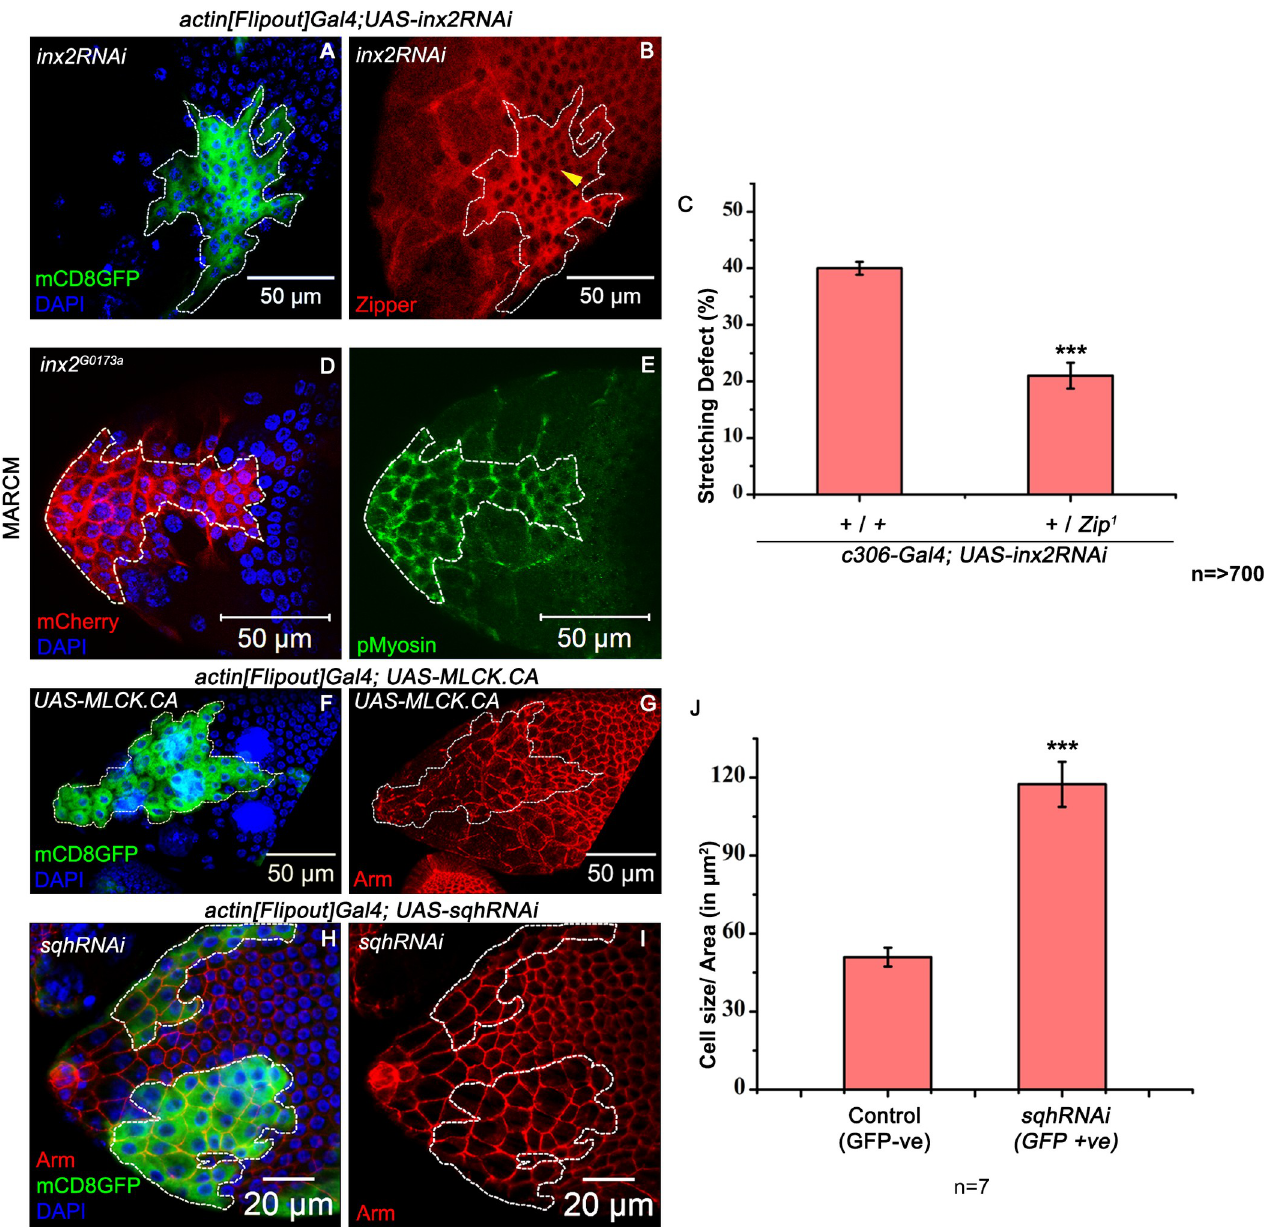
Fig 5. Inx2 influences myosin activity to execute the shape change. (A-B) Mosaic analysis-employing actin[Flipout]-Gal4 resulting in overexpression of inx2RNAi in clones. White dotted outline marks the clone expressing GFP in Green, DAPI in Blue. Anti-Zipper staining is imaged in Red. Elevated levels of Zipper in B. are observed in Inx2-depleted follicle cells compared to the control neighbouring cells undergoing shape change. Yellow arrow head marks the adjacent main body follicle cells of similar size as that of unstretched AFCs. Please note Zipper enriched only in the unstretched AFCs. (C) Quantification of stretching defects for indicated genotypes. Please note the rescue in the stretching defect of the Inx2-depleted follicle cells in zip1/+ background. ��� represents p-value < 0.001. n stands for the number of egg chamber analyzed. (D-E) MARCM analysis with inx2 G0173a allele. mCherry imaged in Red marks the inx2 G0173a mutant clone depicted in white outline. Phospho-myosin is shown in Green. Please note the elevated levels of Phospho-myosin in unstretched AFCs. (F-G) Clonal over expression of constitutively active myosin light chain kinase in the follicle cells (F) Clone is marked in Green (GFP) and highlighted by dotted outline. (G) Anti-Armadillo in Red. Please note that excess myosin activity causes stretching defect in the AFCs. (H-I) Clonal over expression of sqhRNAi mediated by actin [Flipout] Gal4 . Clones are marked in Green and highlighted with a dotted outline. Armadillo in Red and DAPI in Blue. (J) Quantification of the follicle cell area. n = number of follicle cells analyzed. Please note increase in cell area where the Sqh function is down regulated. ��� represents p-value < 0.001. Error bars represent Standard Error of